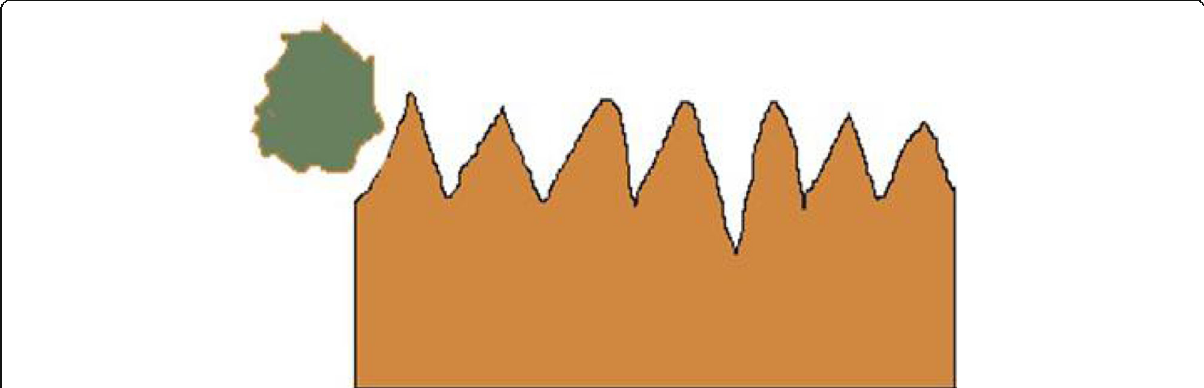
Fig. 1 Sketch of abrasive cutting workpiece. All of the figures are about the effect of impacting direction on abrasive nanometric cutting process with molecular dynamics. Figure 1 is the sketch of abrasive cutting workpiece. In the abrasive flow polishing process, the suspended particles in the medium will flow along the media at a certain speed with the impact of micro cutting workpiece